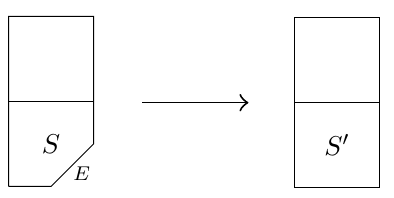
Figure 3 . From left to right: A − 1 curve E neither intersects the gluing curve nor is a part of it. Its flop simply leads to a surface S ′ which is a blow-down of S .